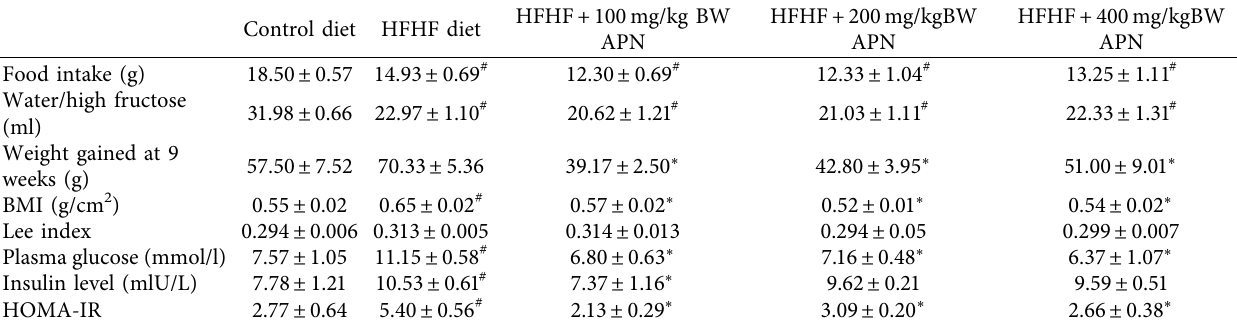
Table 3: Effect of APN on weight gained, lee index, BMI, fasting plasma glucose and insulin level, and insulin